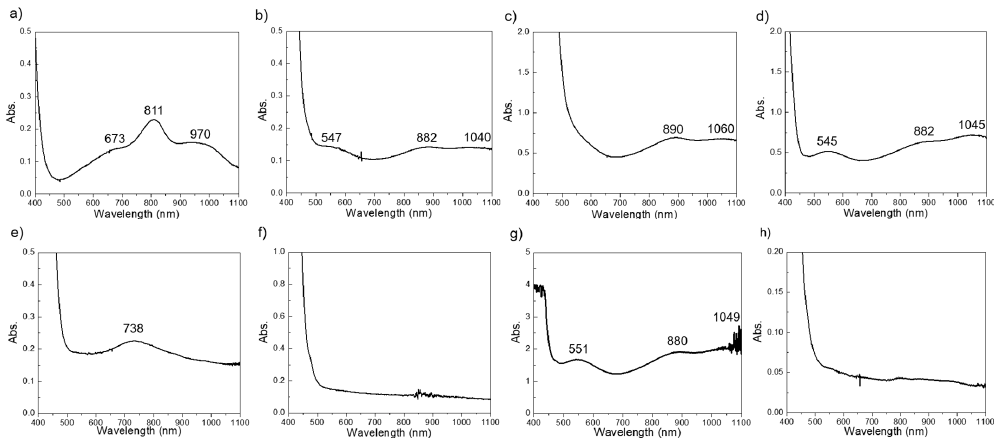
Figure 2. UV-visible spectroscopy characterization of synthesized products diluted in EtOH for experiments 1–8 ( a – h ). The corresponding peaks are labeled if applicable.